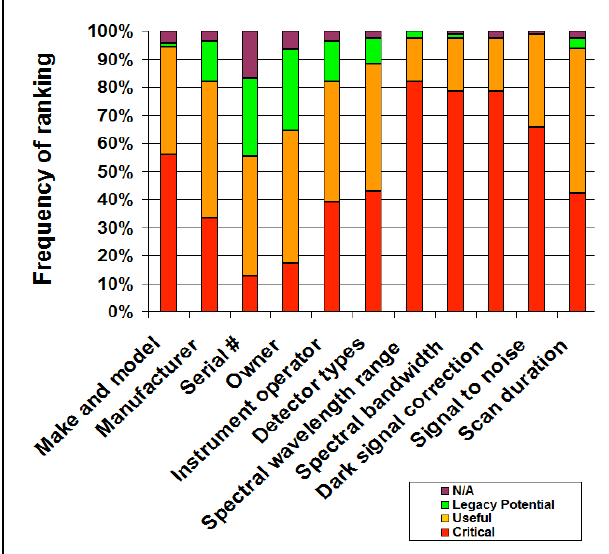
Figure 3.2 Frequency of criticality ranking for ‘instrument’ metadata ( n=79